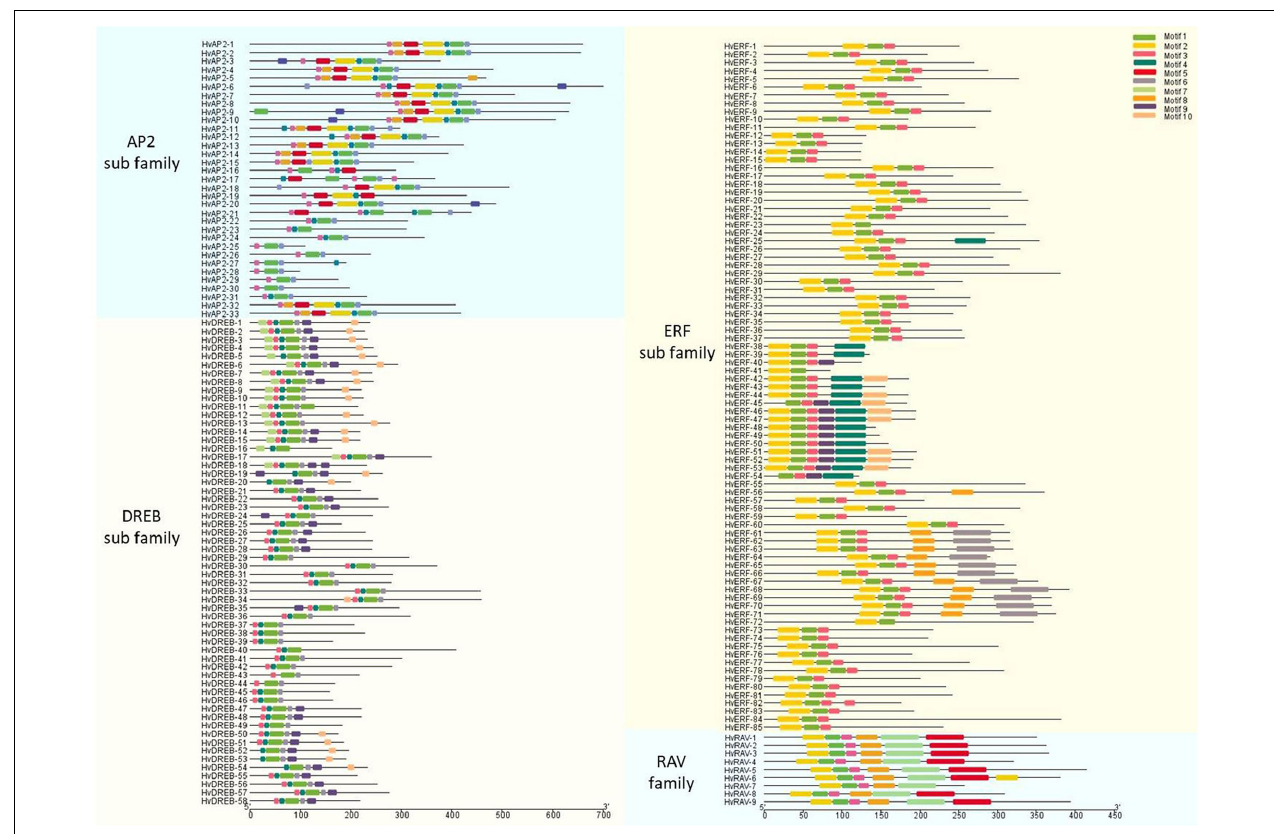
FIGURE 3 | Protein motifs of barley HvAP2/ERF proteins. Conserved motifs in 185 barley HvAP2/ERF proteins. Each subfamily is represented by a different colored box.